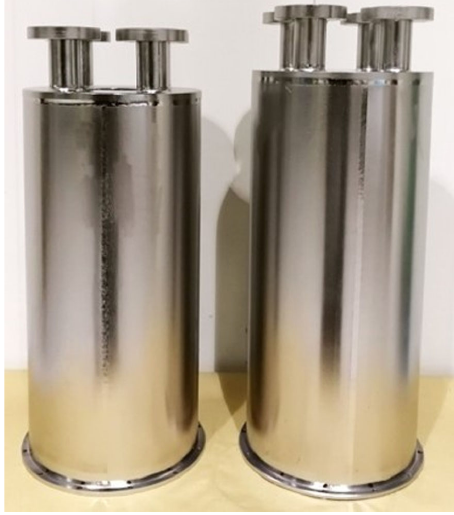
FIG. 1. Photo of the two coaxial cavities.